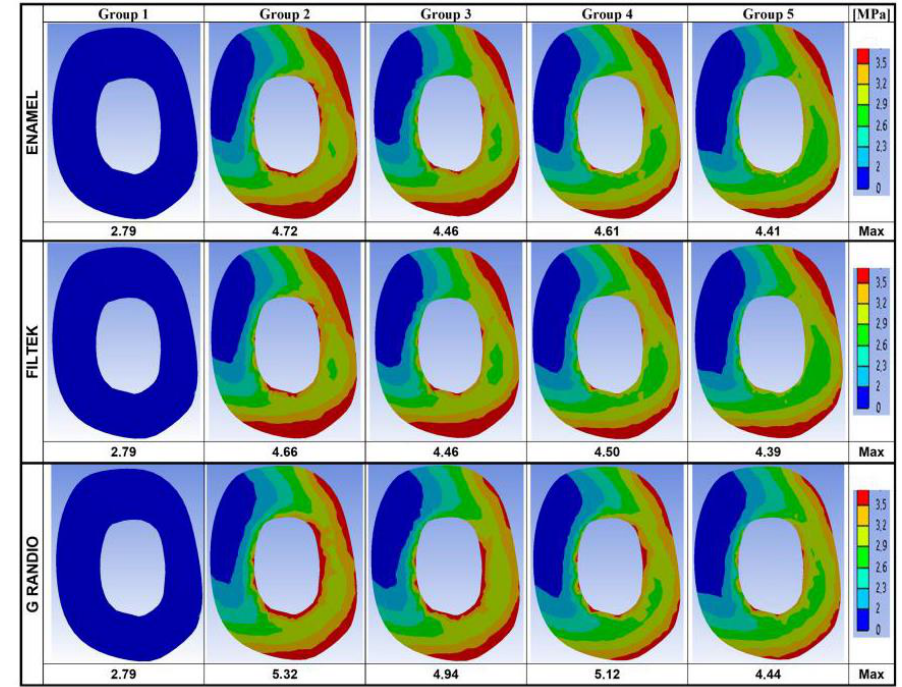
Figure 5. Von Mises maps and Maximum Von Mises stress values (MPa), limited to the radicular dentin, recorded along the level of the alveolar ridge. The legend on the right side shows the colors (and the upper and lower limits) corresponding to the seven stress ranks used to analyze the stress distribution.